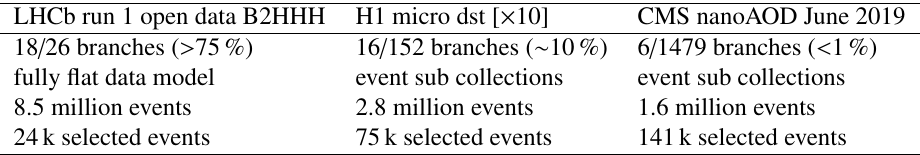
Table 1. Sample analyses for performance evaluation. Main di ff erences are the data model (flat or with collections) and the number of required branches (dense or sparse